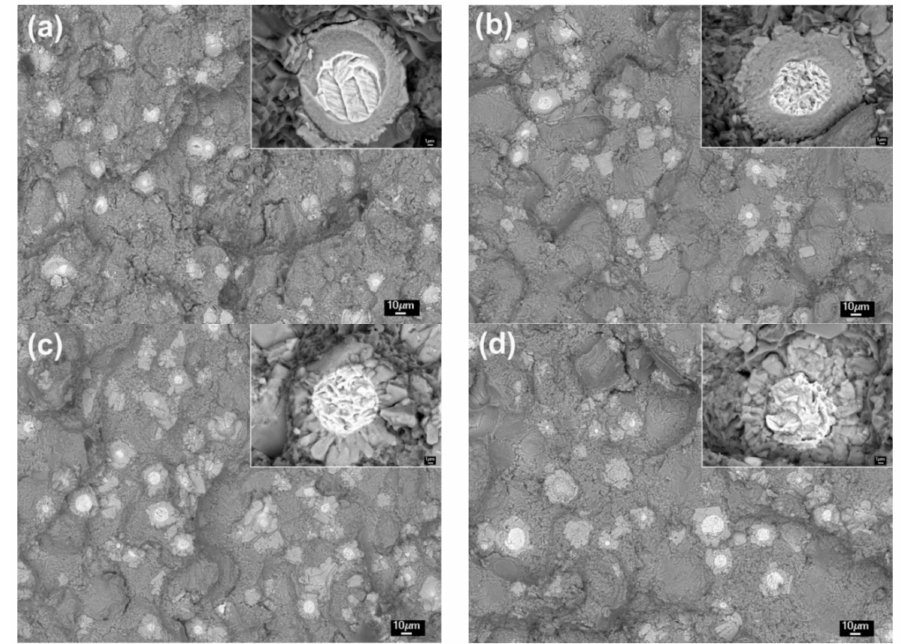
Figure 11. BSE images of fracture surfaces of the composites thixoformed at reheating temperatures of ( a ) 590 ◦ C, ( b ) 600 ◦ C, ( c ) 605 ◦ C, and ( d ) 610 ◦ C. Inserts are the large views of typical fractured reinforcing particles.